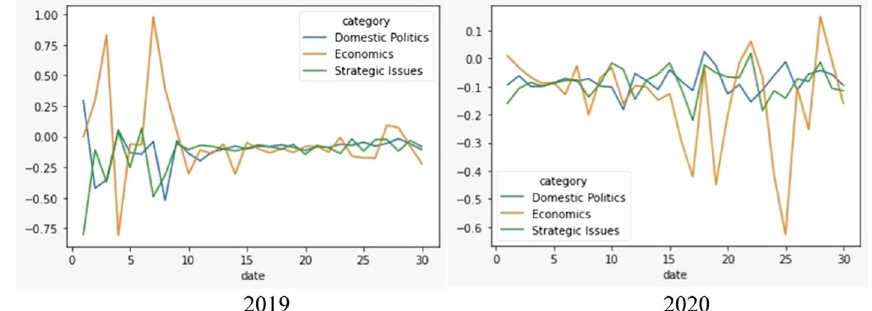
Fig. 12 Sentiment score in RCEP Leaders’ meeting 2019 and